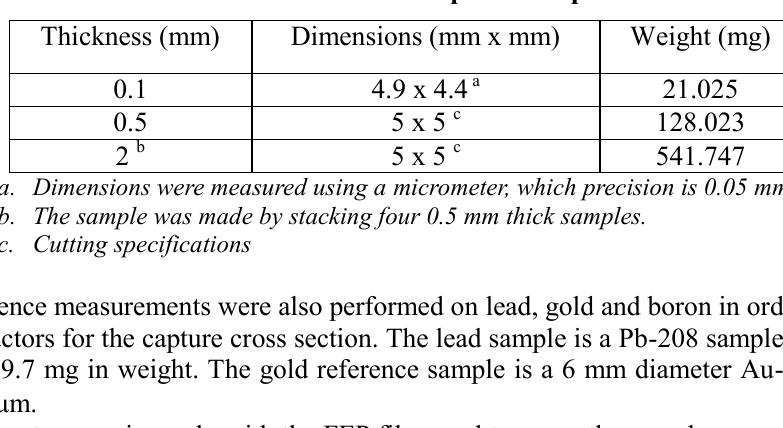
Table I. Characteristics of the Mo samples for capture measurements